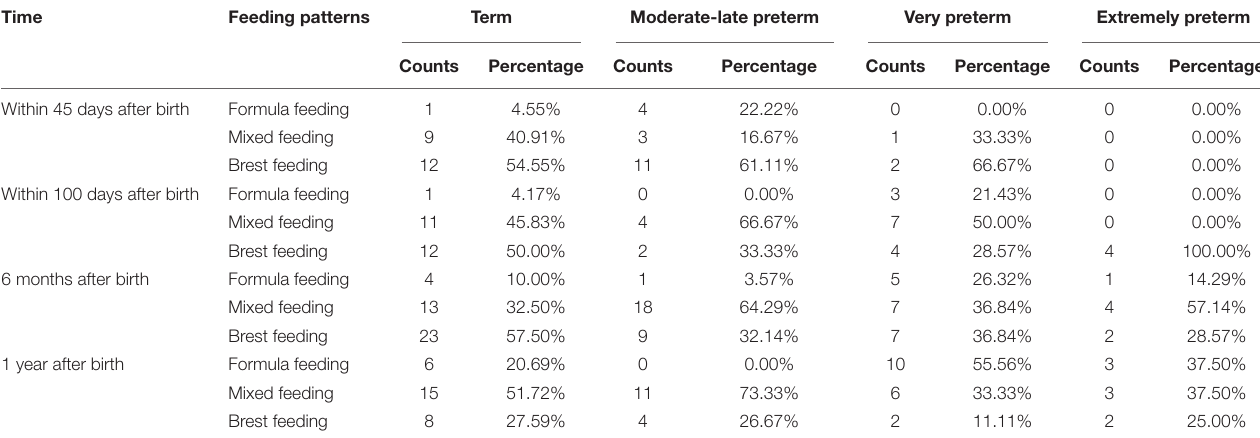
TABLE 2 | Feeding pattern.